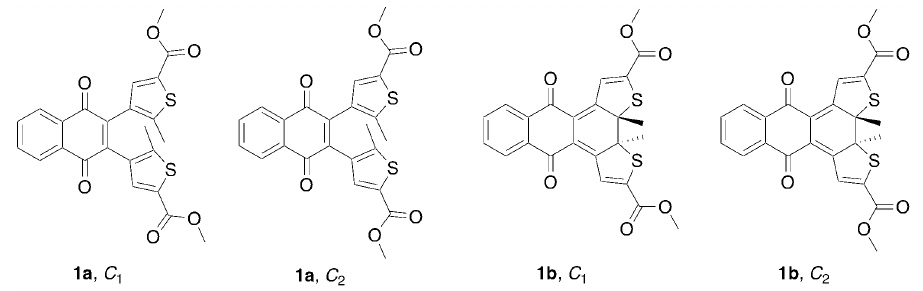
Figure 6. Conformations for compound 1 with symmetry given.